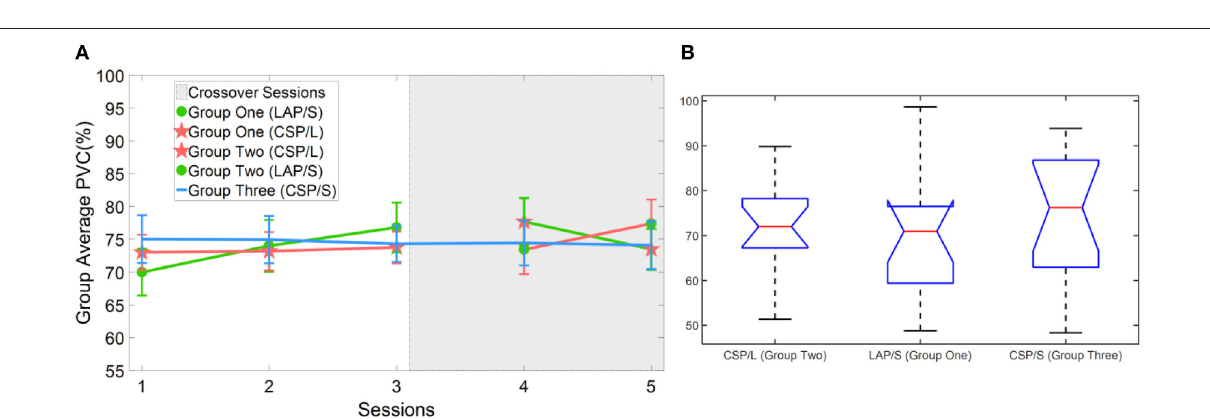
used for all of the LAP/S, CSP/L, and CSP/S groups,